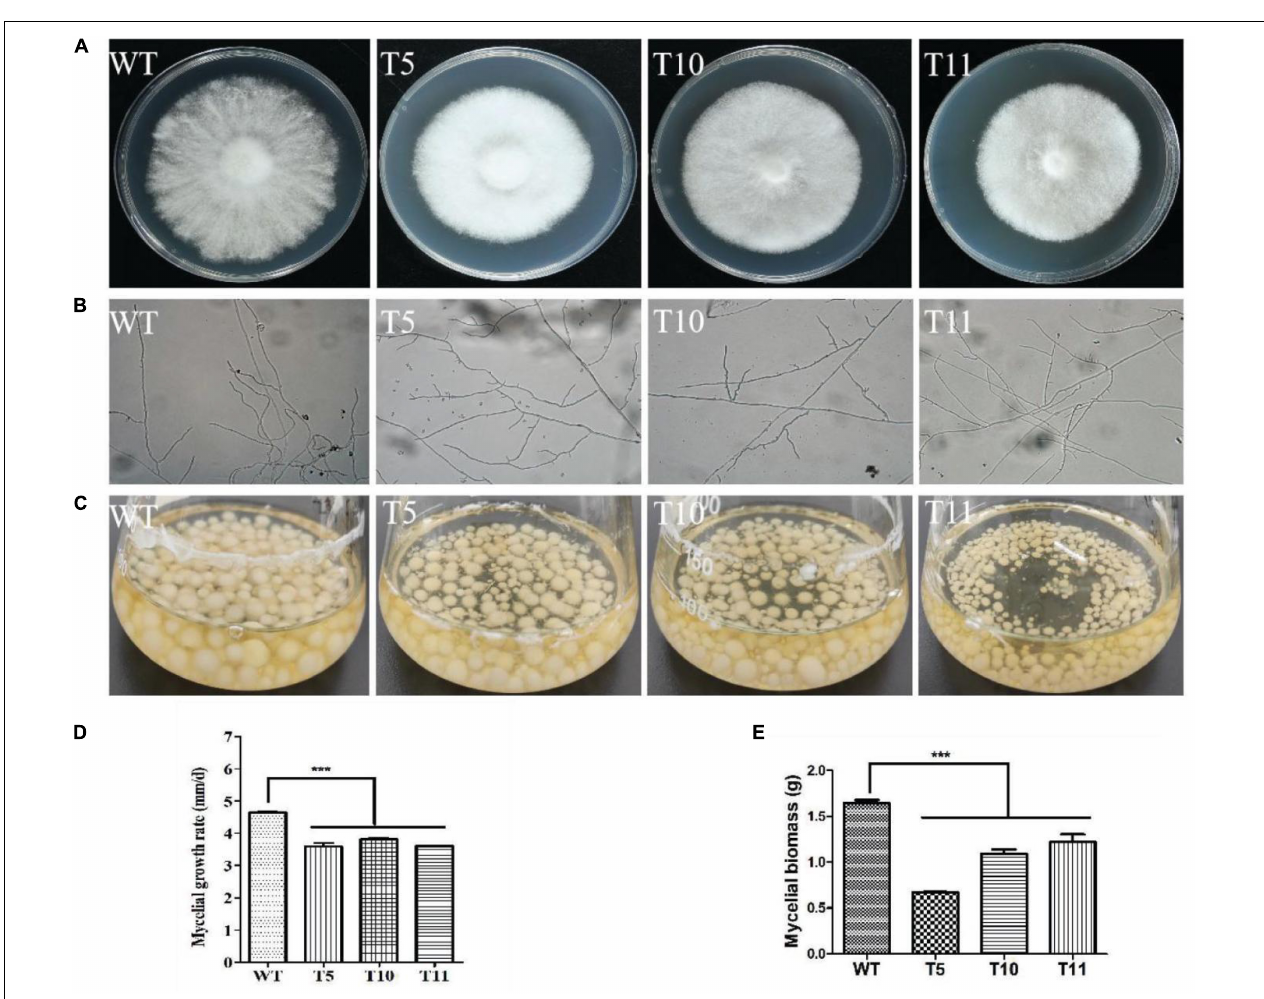
FIGURE 3 | Morphology and growth characteristics of WT, T5, T10, and T11 strains. (A) Colony morphology. (B) Hyphal branch. (C) Culture in liquid. (D) Mycelial growth. (E) Mycelial biomass. Asterisks (***) indicate the data that differed significantly based on p < 0.0001 ( t -test) as the significance threshold.